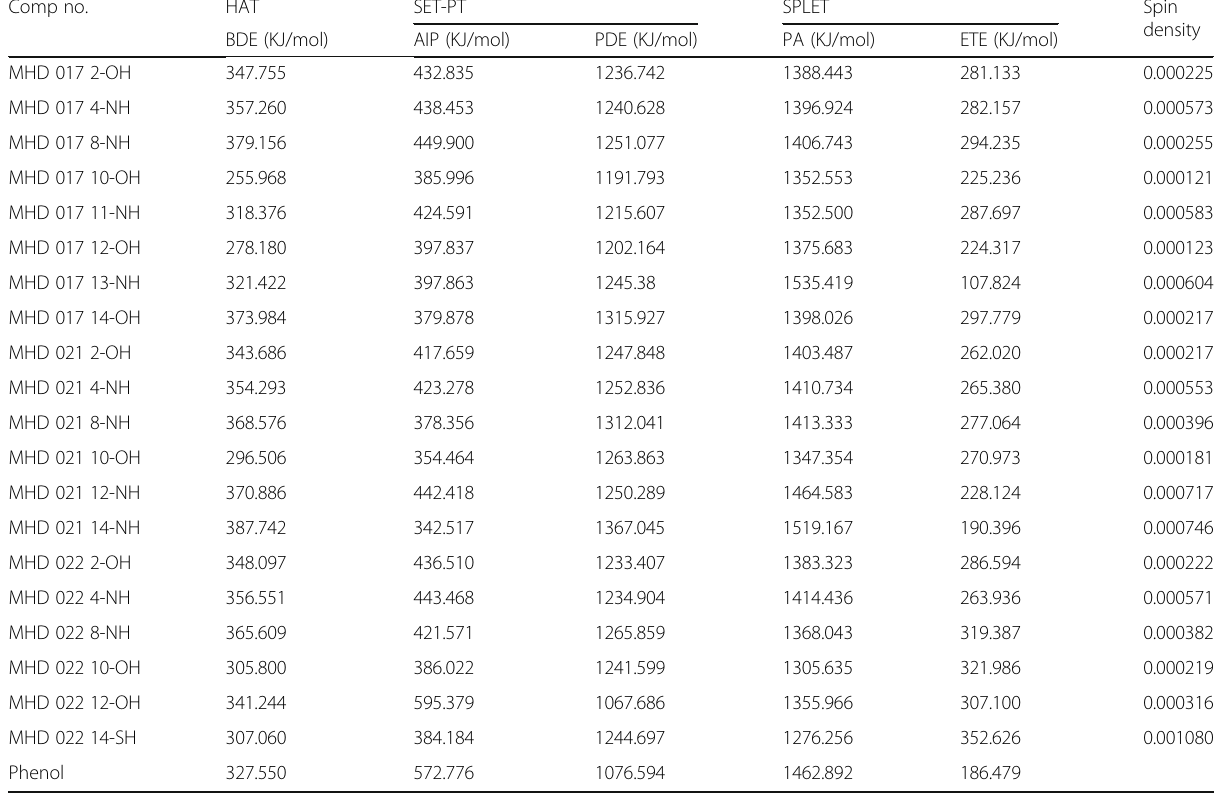
Table 2 Antioxidant properties of designed hydrazone derivatives calculated at the B3LYP/6-311G* level in a vacuum Comp